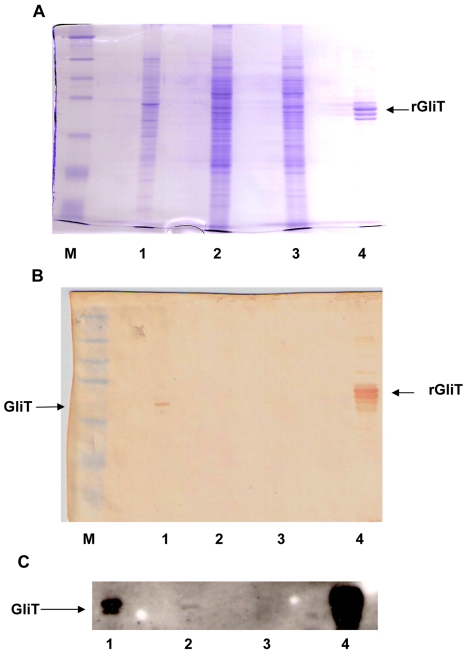
Immunoaffinity purified human IgG detects native GliT in A. fumigatus.(A) SDS-PAGE and (B/C): Western blot analysis of A. fumigatus cell lysates. Immuno-affinity purified human IgG[anti-GliT] was used for Western analysis followed by anti-human IgG-HRP conjugate with visualization by either (B) diaminobenzidine or (C) ECL detection. Lane M: Mr marker: Lane 1: A. fumigatus ATCC26933 lysate (72 h culture); Lane 2: A. fumigatus ATCC46645 lysate (24 h culture); Lane 3: A. fumigatus ATCC46645 ΔgliT lysate (24 h culture) and Lane 4: Recombinant GliT (2 µg). Immunoaffinity purified human IgG to GliT identified GliT in all except A. fumigatus ΔgliT, however ECL substrate was required to detect low level GliT expression in A. fumigatus ATCC46645 (lane C.2).